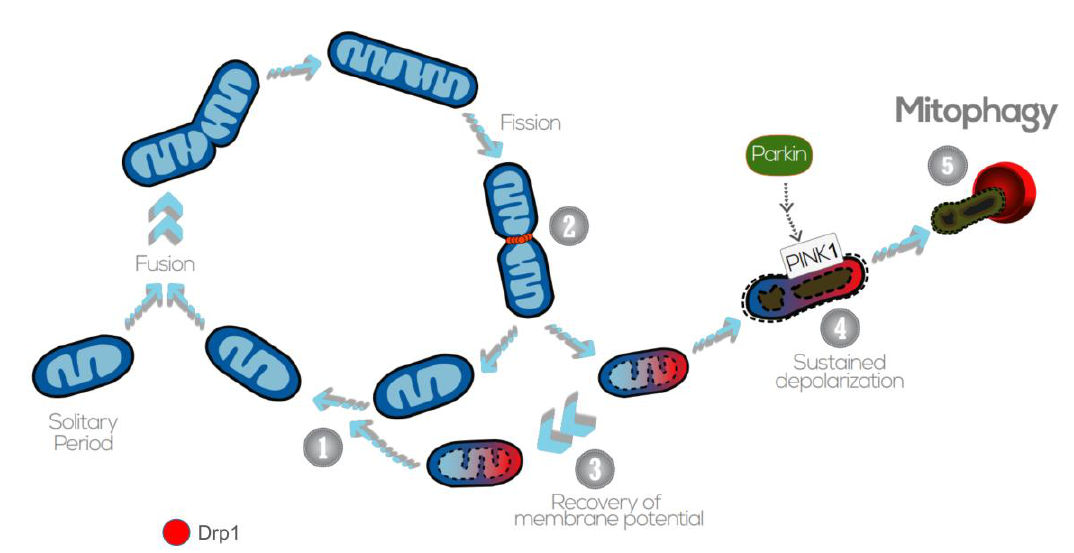
FIGURE 4: The interplay between mitochondrial dynamics and mitophagy. The mitochondrial network shifts between continuous cycles of fusion and fission, each of which can last seconds to minutes. Fission of mitochondria (2) is carried out by the Drp1 GTPase, which is recruited to the OMM from the cytosol. Fission events often generate daughter units with different Δ  m : on the one hand, some mito- chondria are depolarized, but the Δ  m can be restored (3) by fusion with other mitochondria (1). After solitary periods , mitochondria might also fuse if the membrane potential is above a certain threshold. On the other hand, sustained Δ  m depolarization triggers cleavage of Opa1, reduction in Mfn capacity and accumulation of PINK1/Parkin in the OMM (4). This targets single dysfunctional mitochondrion to mitophagy (5), where it is engulfed by the autophagosome. Image adapted from Twig G. and Shirihai O.S. (2011)